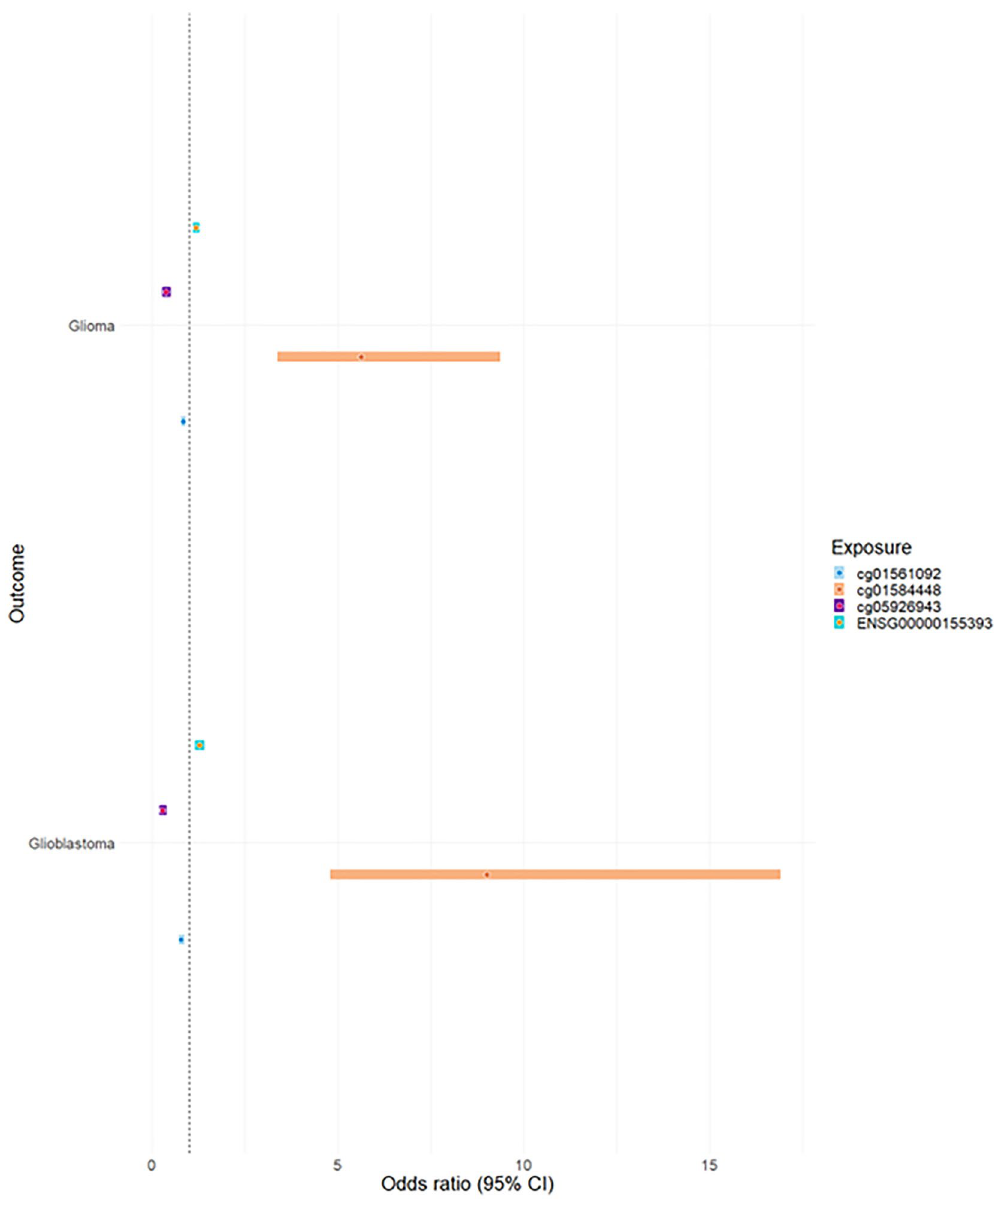
Figure 4. A comparison of MR estimates. Comparison between DNA methylation (DNAm) and gene expression. MR effect estimates are reported as odds ratios (95% confidence intervals (CI)) per 1 standard deviation change in genetically proxied